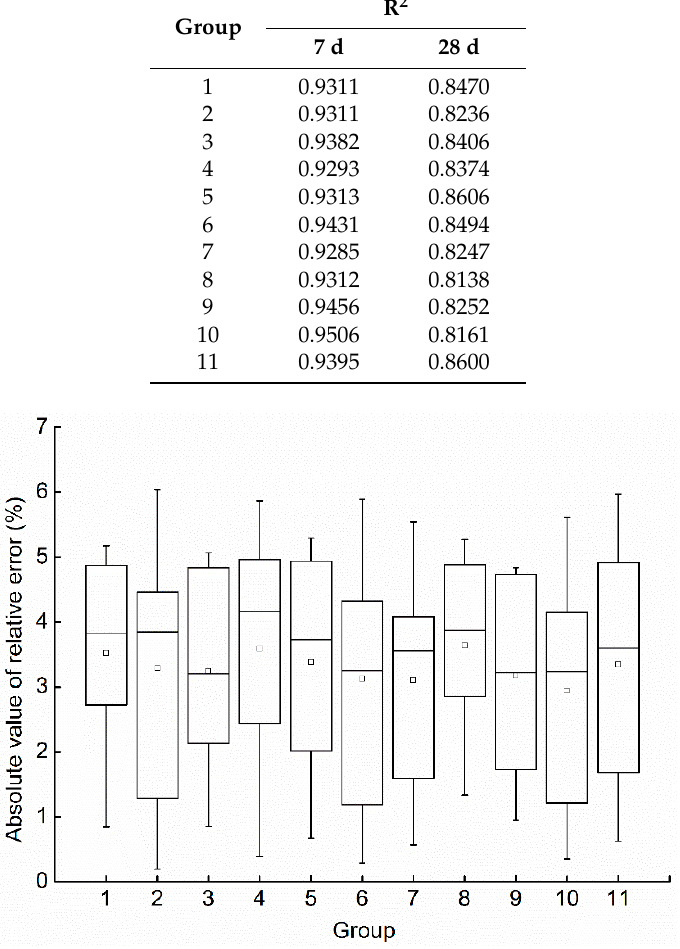
Figure 5. The Box-plot shows the absolute value of the relative error between the tested and fitted